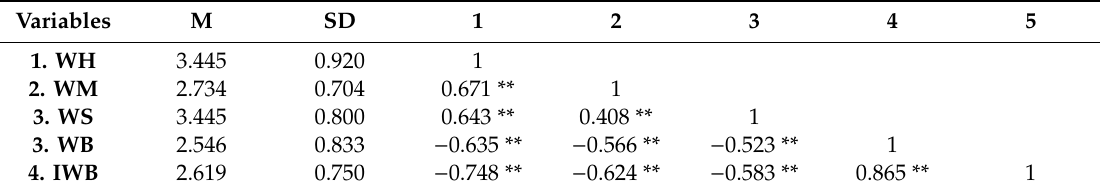
Table 3. Mean, Standard Deviation, and Correlations of